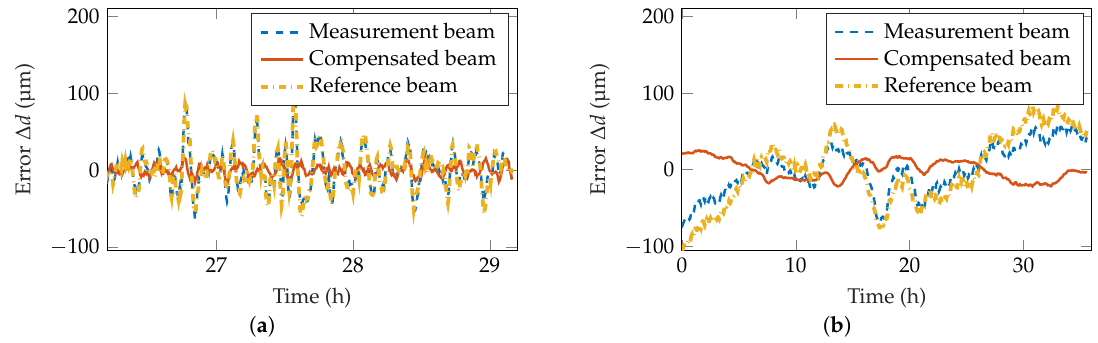
Figure 5. ( a ) Highpass-filtered data showing the compensation of short-term drift effects. A minimum-order filter with a passband frequency of 1.11mHz, steepness of 0.85 and stopband attenuation of 60dB was applied. ( b ) Lowpass-filtered data showing the compensation of long-term drift effects. A moving average filter with a window length of 1h was applied.